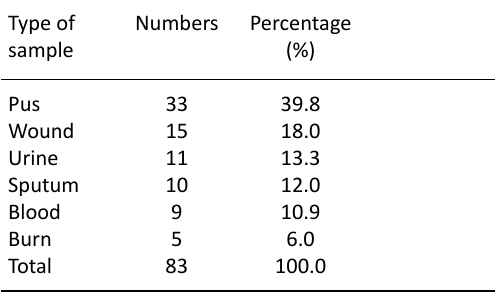
Table 4. Percentage and numbers of S. aureus according